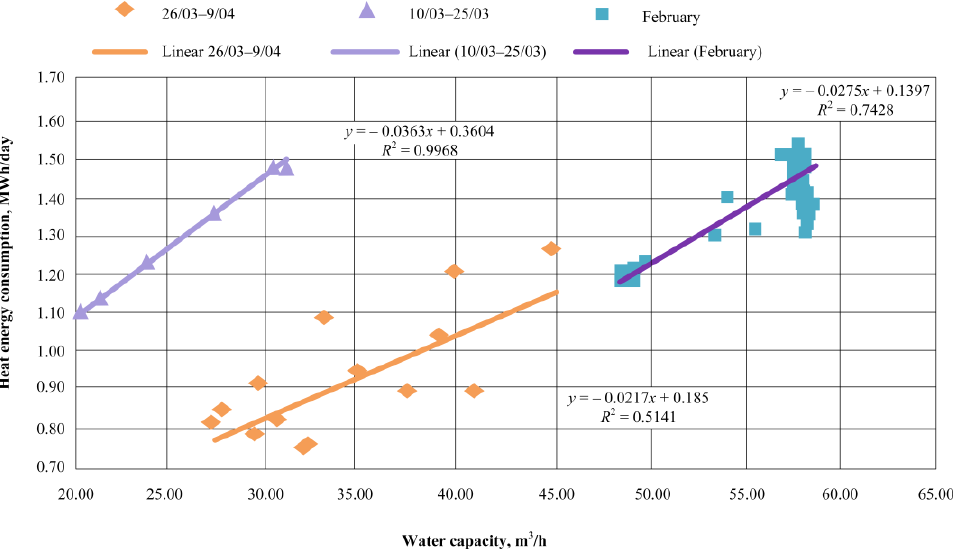
Fig. 7. Heat consumption depending on mass flow